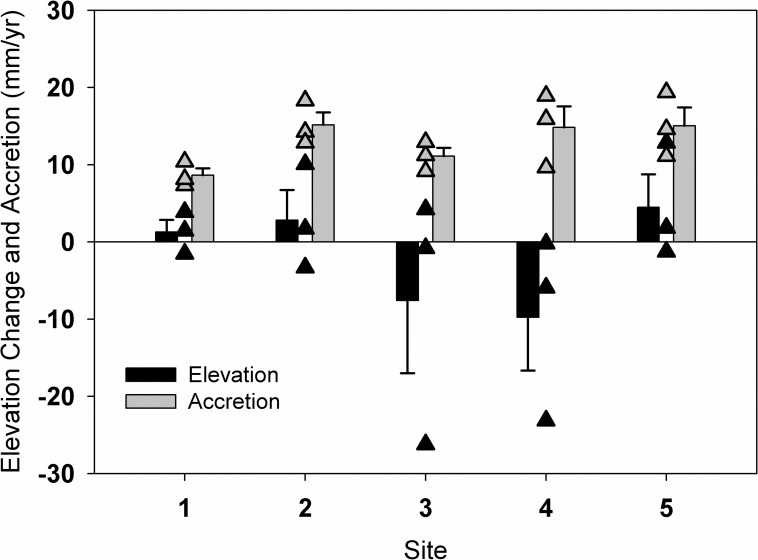
Elevation change (black bars and triangles) and surface accretion (gray bars and triangles) at 5 sites across the Nanticoke River subestuary of Chesapeake Bay.Site numbers 1–5 proceed from downstream brackish marshes to upstream tidal freshwater marshes. Bars represent mean +1 SE of elevation change or accretion rate across 3 replicate subsites, depicted individually as triangles. Rates reflect measurements made from October 2007 through October 2011.